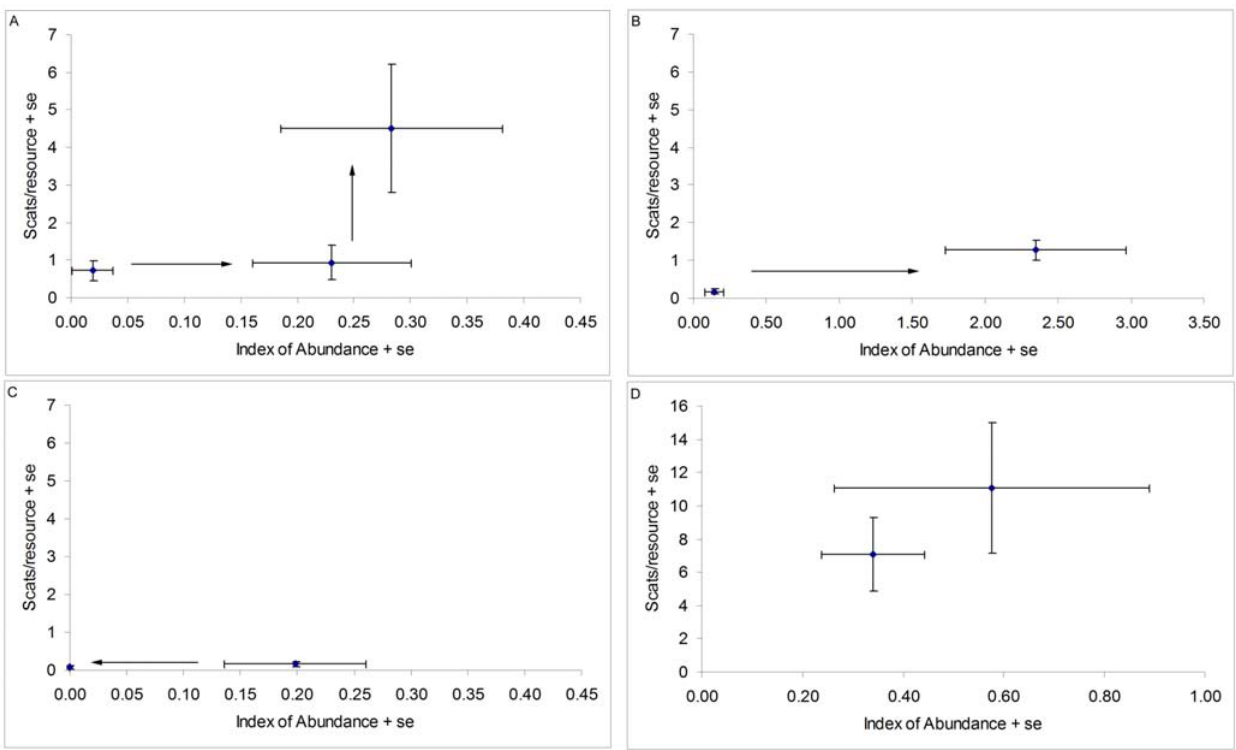
Figure 4. Effect of relaxation or intensification of control on dingo abundance and scent-marking behavior. (a) Relaxation of control (Red Lake 2006–2008); (b) intensification of control during a productive period (Andamooka 2007–2008); (c) intensification of control during a dry period (Nantawarrinna 2007–2008); and (d) no control in both years (Curdimurka 2007–2008). Arrows denote the direction of meaningful significant changes between the years.